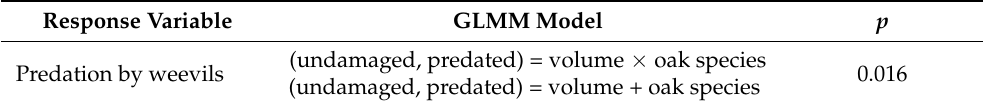
Table 3. Generalized linear mixed effects models (GLMMs) used to analyze the effects of seed volume and oak species in pre-dispersal predation by weevils. The p -value indicates the significance of the likelihood ratio test among the pair of models ( n =